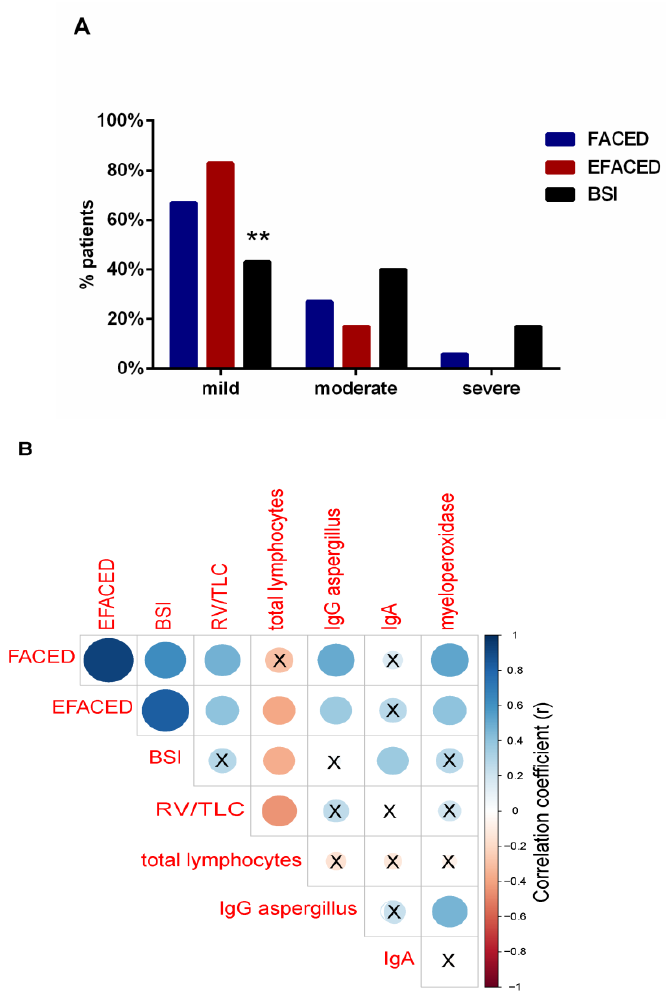
Figure 2. ( A ) Histograms of the proportions of patients according to disease severity: mild, moder- ate, and severe, according to FACED (blue histograms), EFACED (red histograms), and BSI (black histograms). Statistical significance: ** p ≤ 0.01 between BSI and EFACED proportions of patients. ( B ) Correlation matrix of the disease severity scores and analytical variables, in which positive corre- lations are represented in blue, while negative correlations are represented in red. The intersection within the circle represents p value > 0.05. Color intensity and the size of the circle are proportional to the correlation coefficients, as indicated in the Y axis on the right-hand side of the graph.